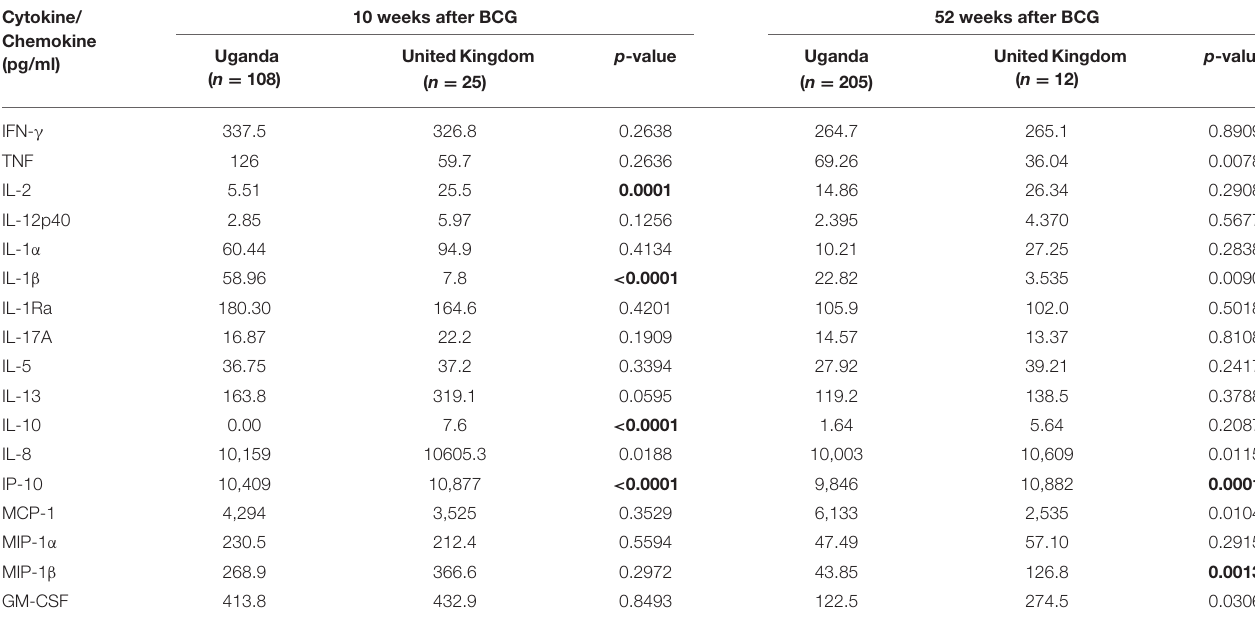
TABLE 2 | Median responses to PPD in infants from Uganda and United Kingdom at 10 and 52 weeks following BCG immunization. Cytokine/